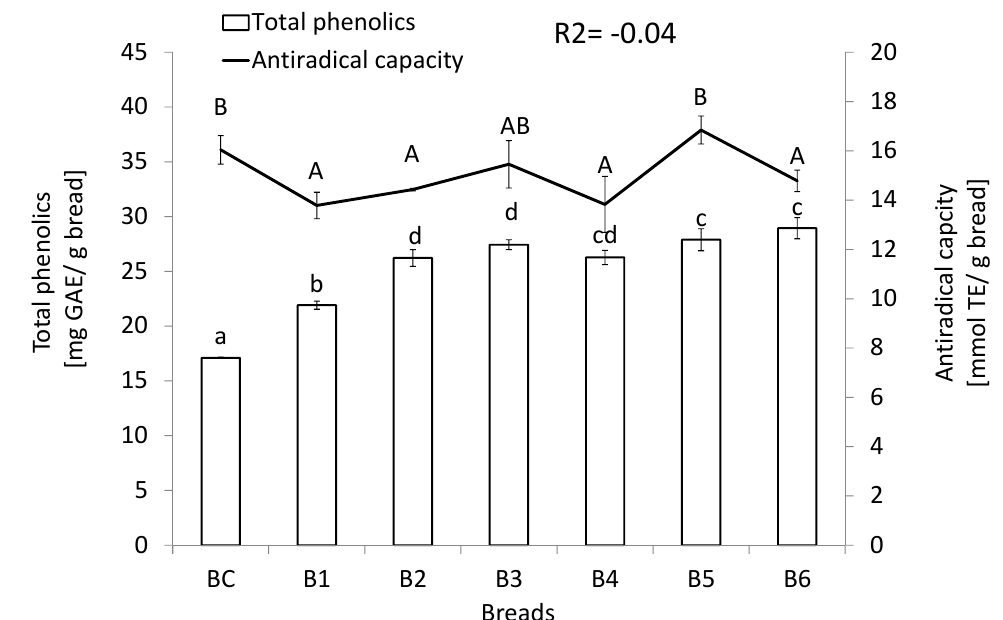
Figure 1. Phenolics content and antiradical capacity of the potential bio-accessible fraction of studied breads. Means ( n = 6, ± standard deviation) followed by different lower-case letters are significantly different at p < 0.05. BC—control bread; B1—bread enriched with milk and poppy; B2—bread enriched with carum, amaranth, and seeds; B3—bread enriched with hazel nuts, seeds, and amaranth flour; B4—bread enriched with milk, amaranth flour, and seeds; B5—bread enriched with amaranth flour, seeds, yolk, and carum; B6—bread enriched with milk, amaranth flour, seeds, and poppy; TE—Trolox equivalent; GAE—gallic acid equivalent. Table 3. Influence of buckwheat bread on biochemical parameters in rats.